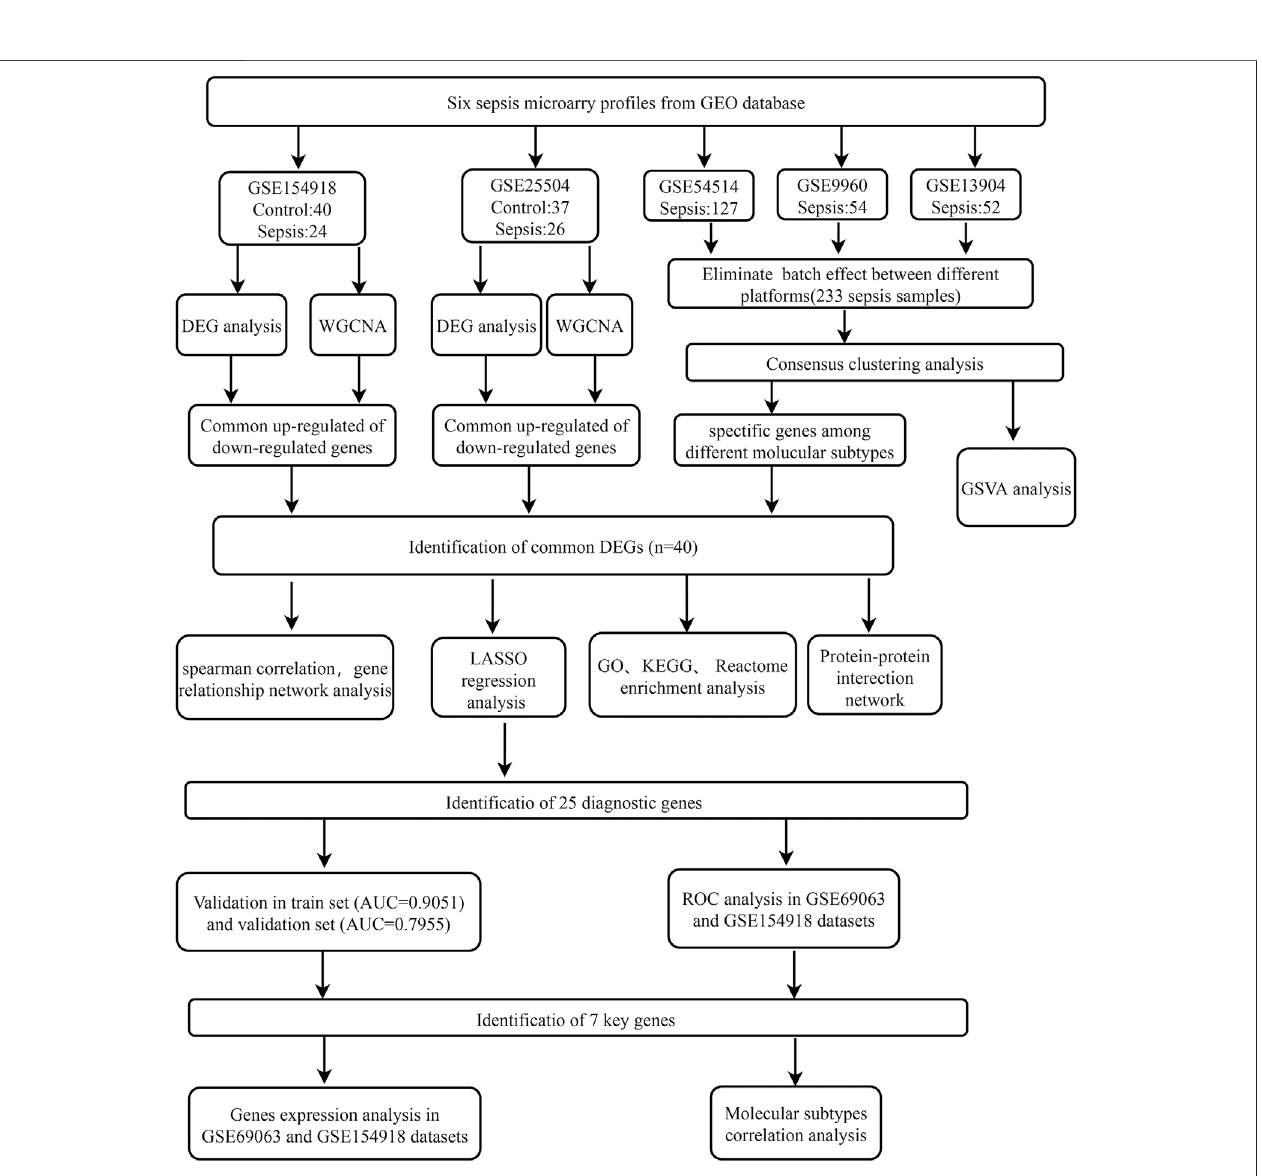
FIGURE 1 | Flowchart for bioinformatics analysis in this study. The following datasets were used for screening potential diagnostic genes and mechanisms associatedwiththeprogressofsepsis(GSE154918andGSE25504datasets)andthesepsismolecularsubtypes(GSE54514andGSE9960,andGSE13904datasets). Abbreviations: GEO, Gene Expression Omnibus; DEG, differentially expressed genes; WGCNA, Weighted gene co-expression network analysis; GSVA, gene set variationanalysis;GO,GeneOntology;KEGG, KyotoEncyclopedia ofGenesand Genomes;AUC, areaunderthecurve;LASSO,Theleastabsoluteshrinkageand selection operator; ROC, Receiver operator characteristic